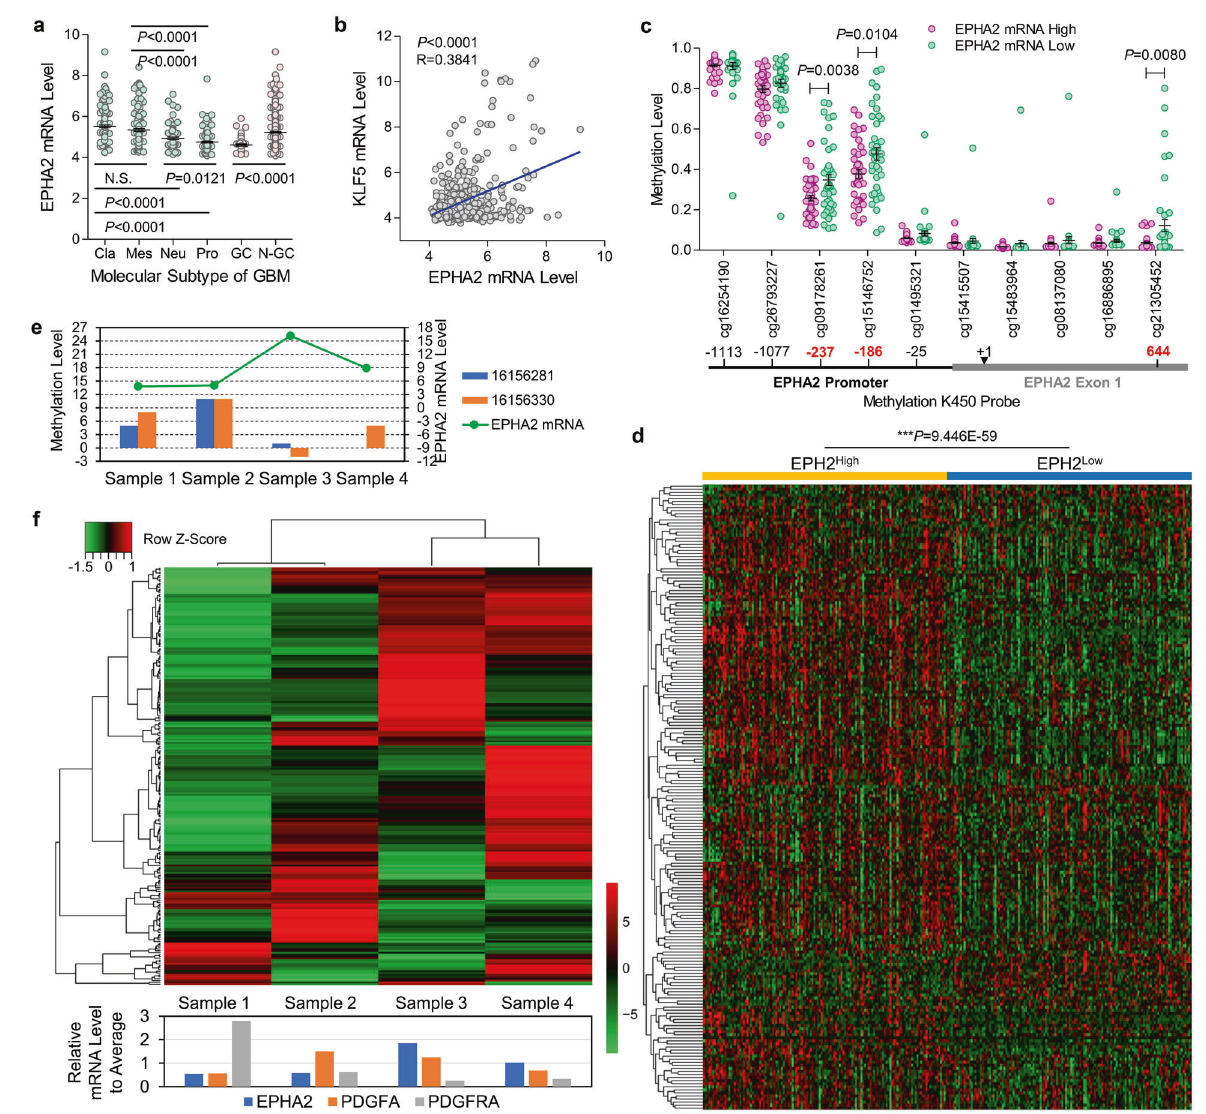
Fig. 3 EPHA2 expression regulation and relationship with PDGF downstream targets. a EPHA2 expression in different molecular subtypes of GBM in TCGA_GBM database. b Pearson correlation of EPHA2 and KLF5 in TCGA_GBM database. c Methylation levels of EPHA2 promoter region measured with methylation K450 probes. d Heatmap cluster analysis of PDGF signaling target genes with EPHA2High vs. EPHA2Low in TCGA_GBM database. e The methylation level in promoter region corresponding to two critical probes at EPHA2 promoter from TCGA_GBM and the EPHA2 mRNA level in four tumor foci from a multifocal GBM patient. f Upper: Heatmap cluster analysis of PDGF signaling target genes in the four tumor foci; Lower: mRNA expression of EPHA2, PDGFA, and PDGFRA in the four tumor